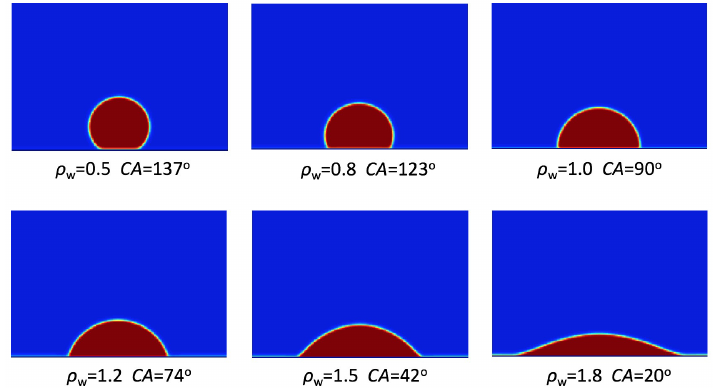
Figure 5. The equilibrium contact angle (CA) changes with ρ w : The red region is liquid; the blue region is vapor; the bottom is solid wall; the whole field is isothermal with T = 0.7.